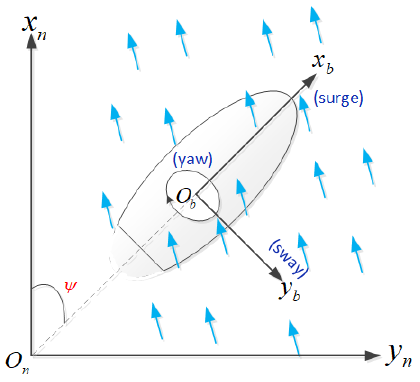
Figure 1. AUV motions in the inertial coordinate system { n } and the body-fixed coordinate system { b } with ocean currents in the horizontal